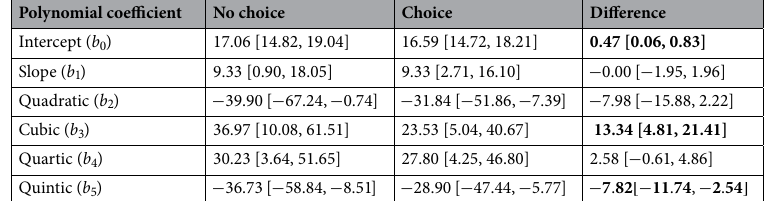
n ) 3, 6, 9, 12, 18, 30, 45 with t = [ ]